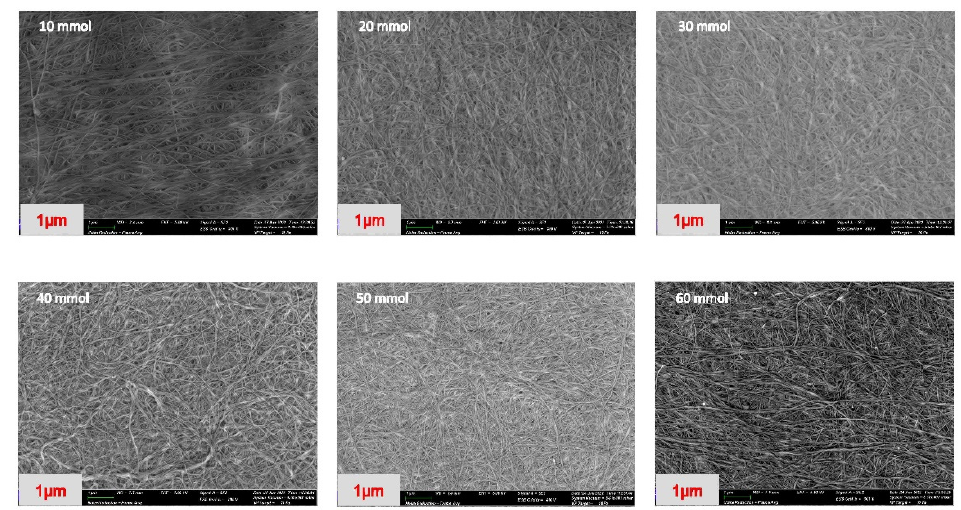
Figure 2. SEM morphology of phosphorylated NdC (10–60 mmol). Table 1. Fiber size (diameter) of phosphorylated Nata de Cassava membranes.